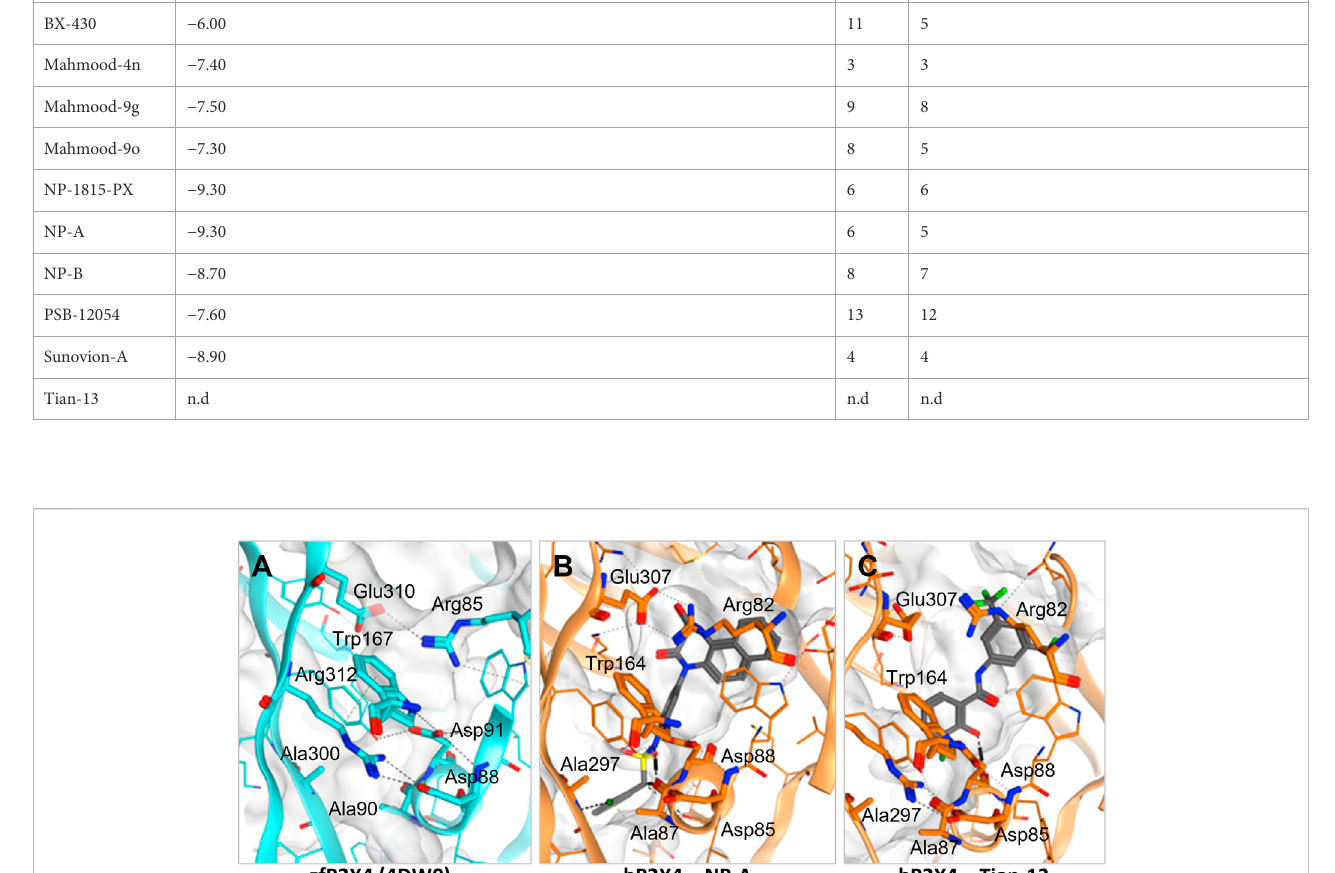
Figure 4; Supplementary Figure S1) which suggests that interaction